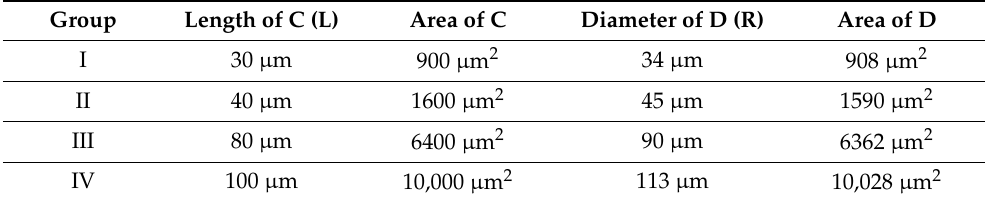
Table 1. Specific dimensions of C and